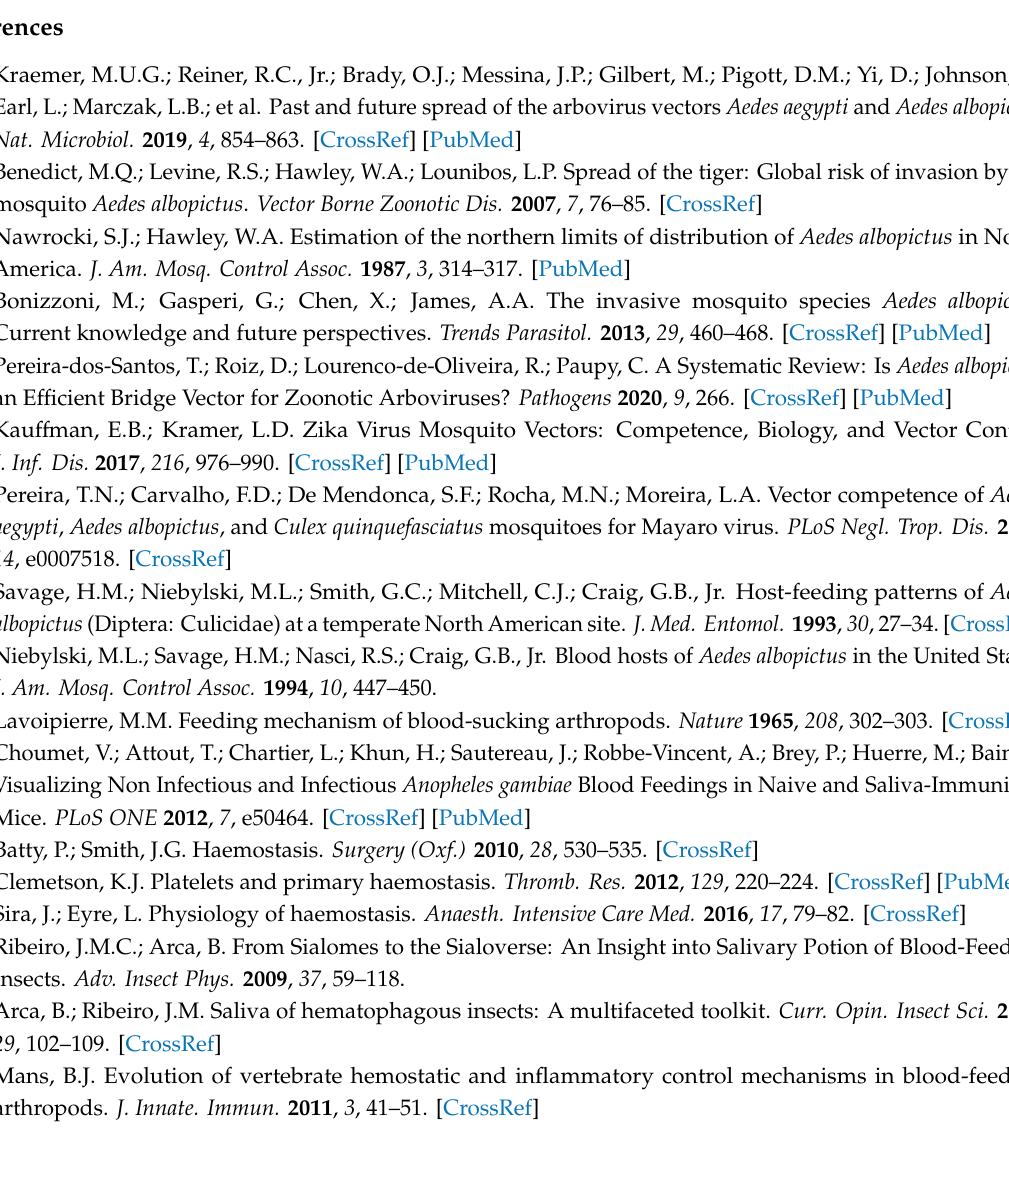
Figure S1: Comparison of binding a ffi nities of several mosquito D7 salivary proteins to biogenic amines and biolipids involved in hemostasis. Figure S2: Binding pockets prediction of AlboD7L1 for eicosanoids and biogenic amines. Figure S3. AlboD7L1 inhibits pro-aggregatory e ff ects of the thromboxane A 2 analog U-46619, low doses of collagen but not